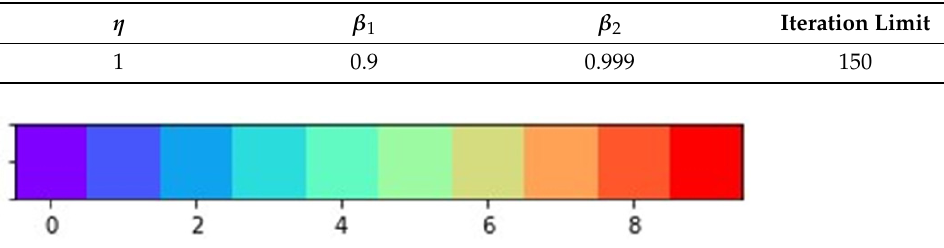
Table 1. Parameters of the Adam optimization algorithm.